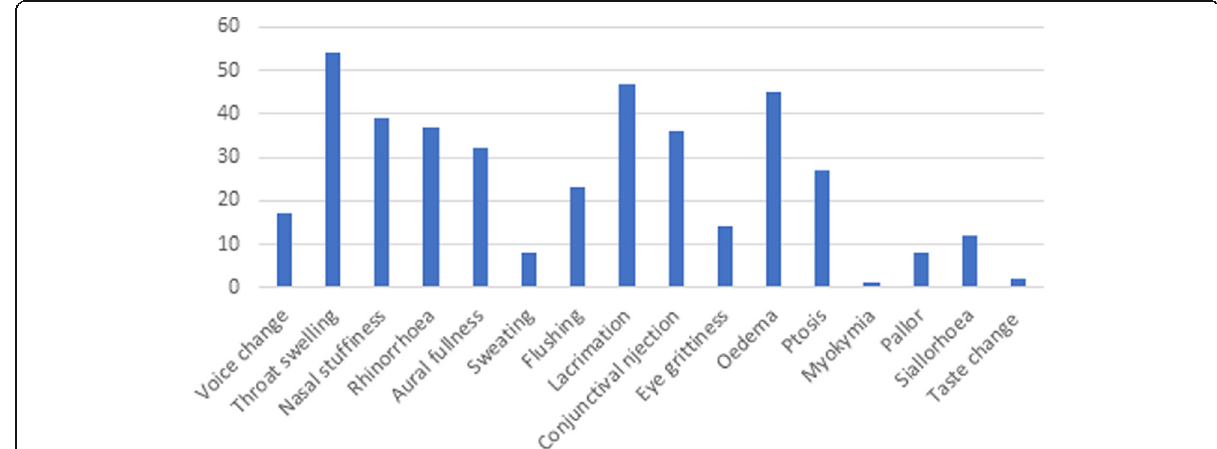
Fig. 4 Summary of phenotype of CAS reported by cohort 2. The y axis represents the number of patients reporting each